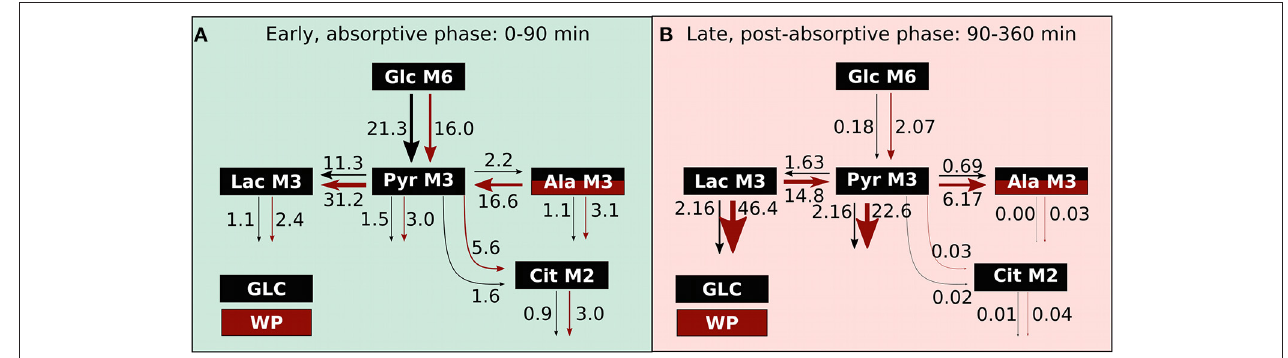
FIGURE 8 | Metabolic fluxes alterations upon GLC and WP intake. Overview of the metabolic flux changes ( µ M/min) in GLC (black) and WP (red) intervention in the (A) early and (B) late postprandial